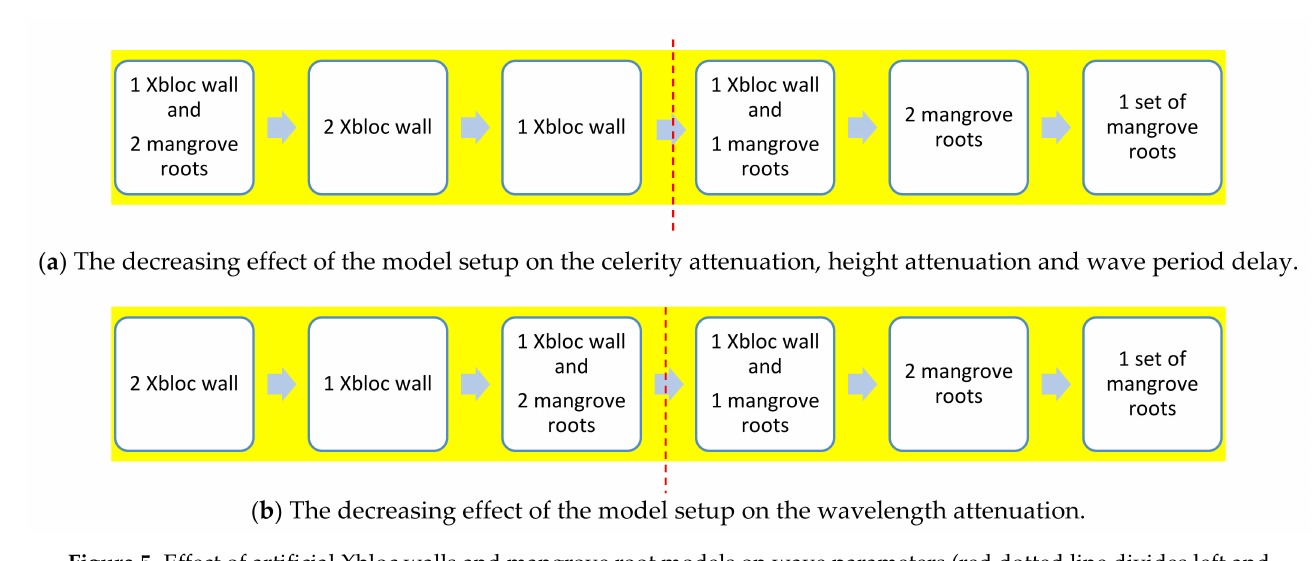
Figure 5. Effect of artificial Xbloc walls and mangrove root models on wave parameters (red dotted line divides left and right halves of the figures to distinguish the first three from the last three models). Table 2. Average wave measurement results for six different model combinations of Xbloc walls and mangrove roots (each combination was repeated 10 times, and the details are given in Appendix